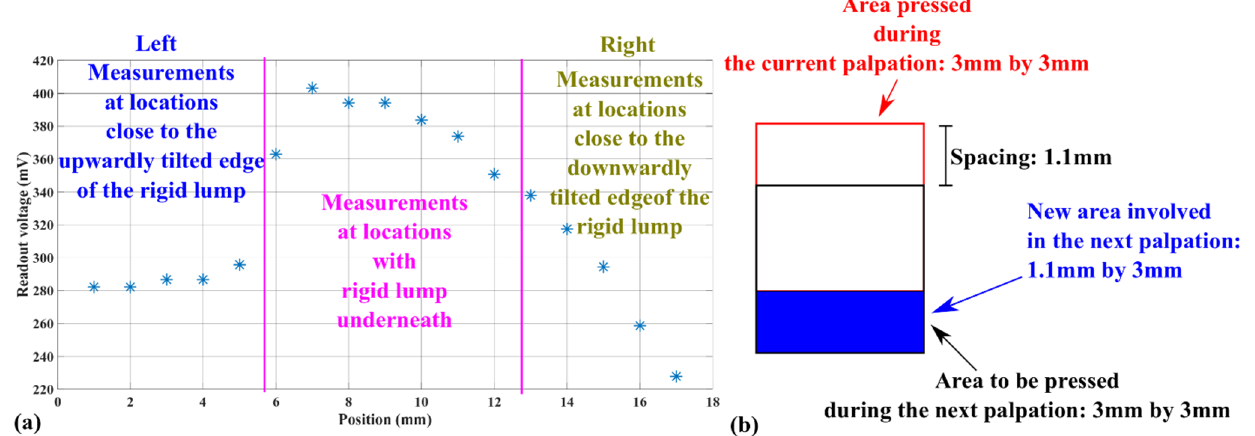
Figure 13. Voltage readout corresponding to the line scanning of palpations on a self-made tissue phantom. ( a ) The voltage readout, ( b ) The schematic depicting how the tactile sensor is moved between each palpation.